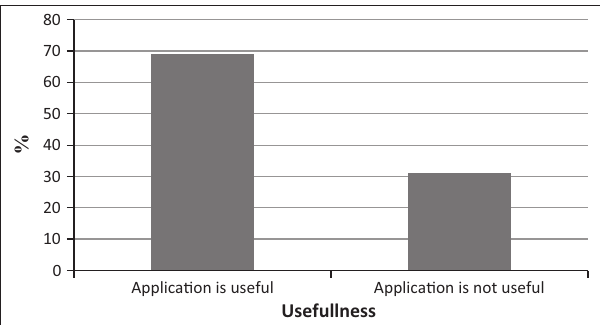
FIGURE 7: Perceived usefulness of the application.